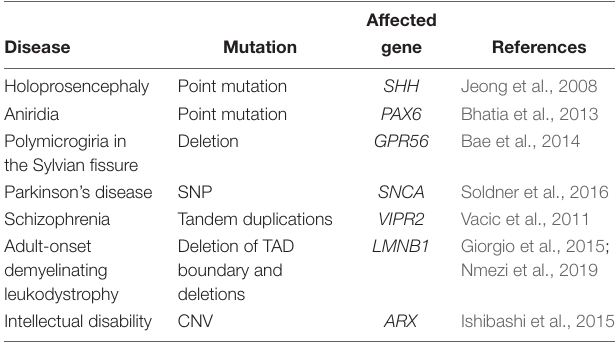
TABLE 3 | Alterations of non-coding regulatory elements in diseases related to the central nervous